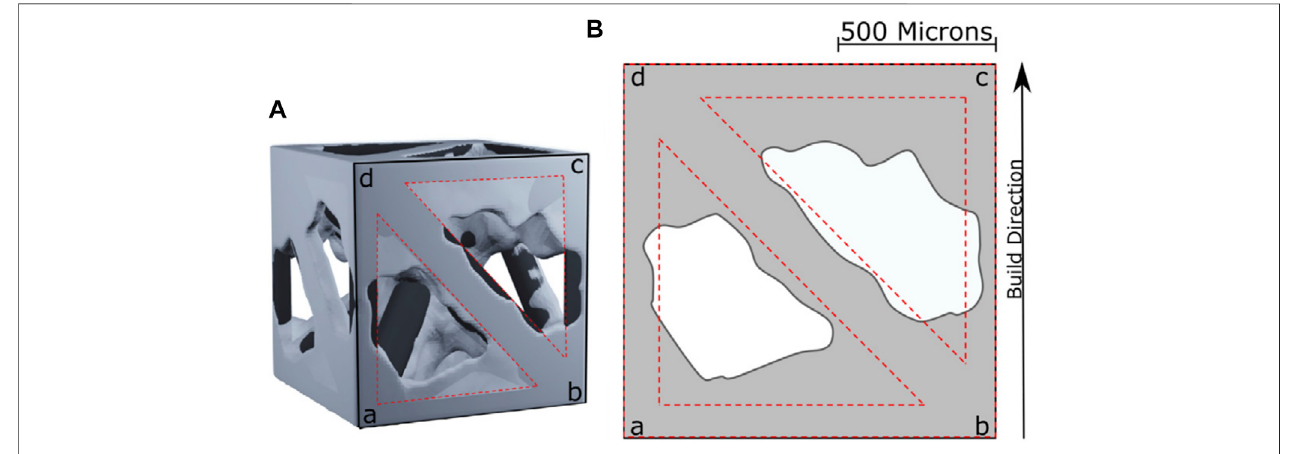
FIGURE 8 | (A) 3D reconstruction of a unit cell. (B) Discrepancy between design parameters and manufactured parameters (Arabnejad et al., 2016).